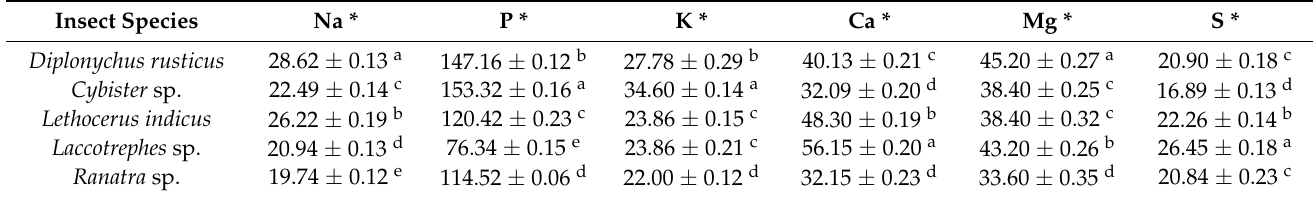
Table 2. Composition of macroelements of five aquatic insect species (mg/100 g, d.w.) 1